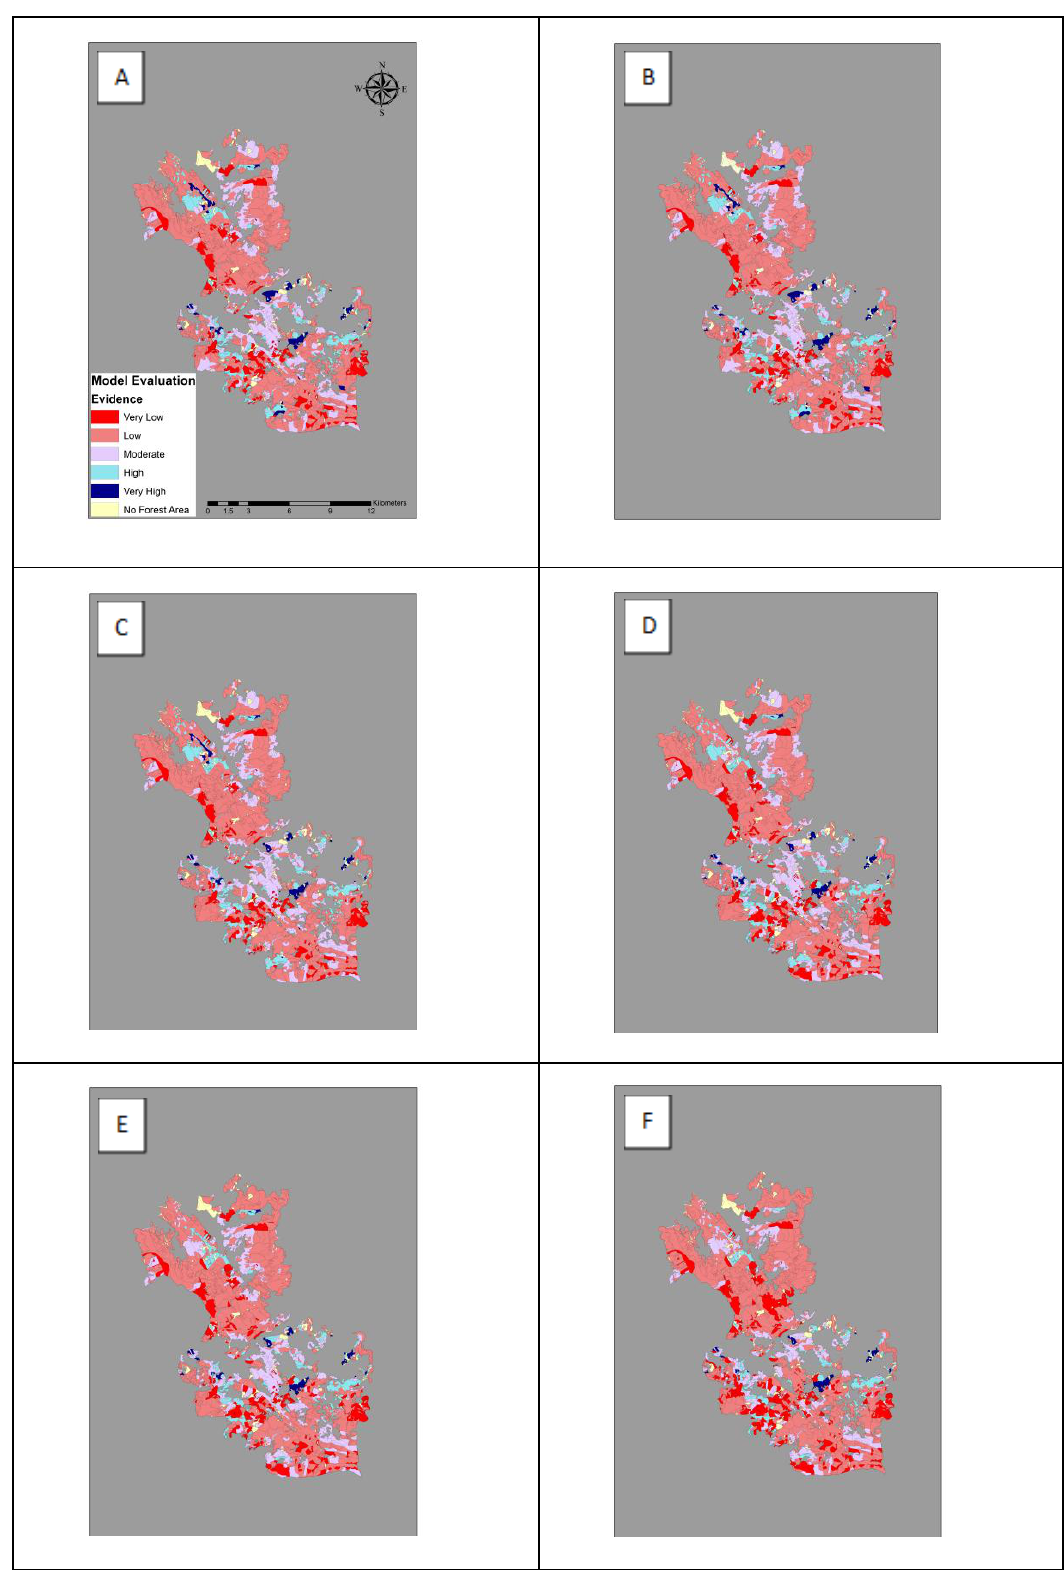
Figure 7. Evaluation of individual stands for solutions A to F from the Pareto frontier (Figure 3) with the values of variables per ha using the same NetWeaver model used for evaluating the best point (Figure 6). The percentile 90 was used as the maximum.